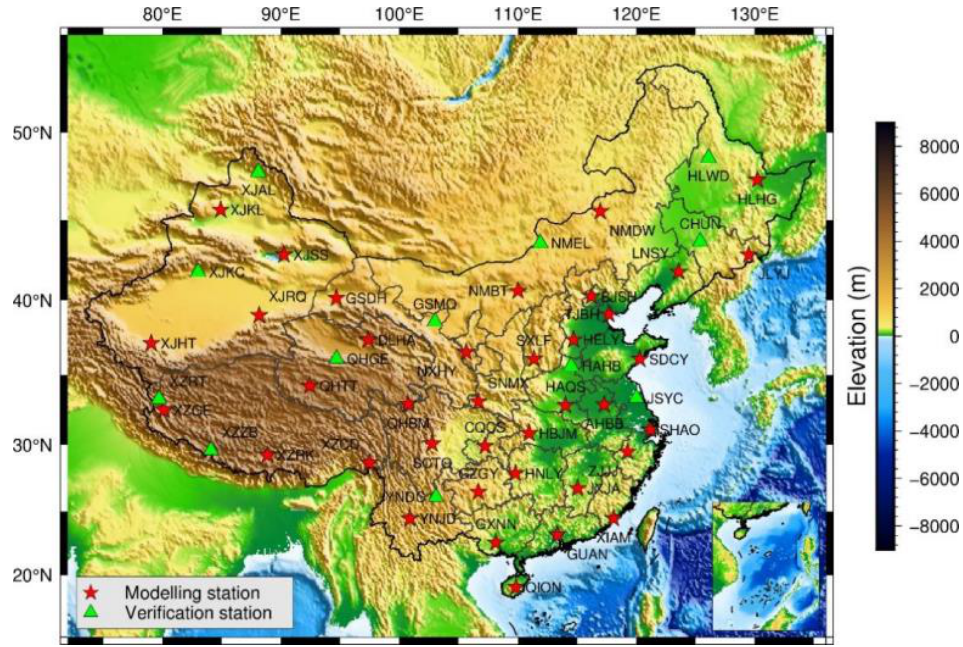
Figure 1. Spatial distribution map of the 50 selected GNSS stations in the China region. Table 1. Locations of 38 GNSS stations for PWV modelling in the China region.